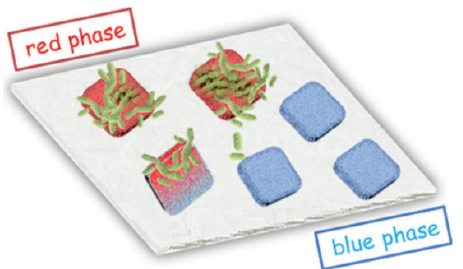
Figure 10. The red and blue chromatic solgel/polydiacetylene (PDA) thin films, assembled through a dip-coating technique, enable in situ colorimetric and fluorescent detection of bacterial biofilm formation (see figure). Interestingly, the gel-embedded PDA domains promote biofilm accumulation. The sol-gel/PDA assembly can also be employed for high-throughput screening of biofilm inhibitors. Reprinted with permission from [82].